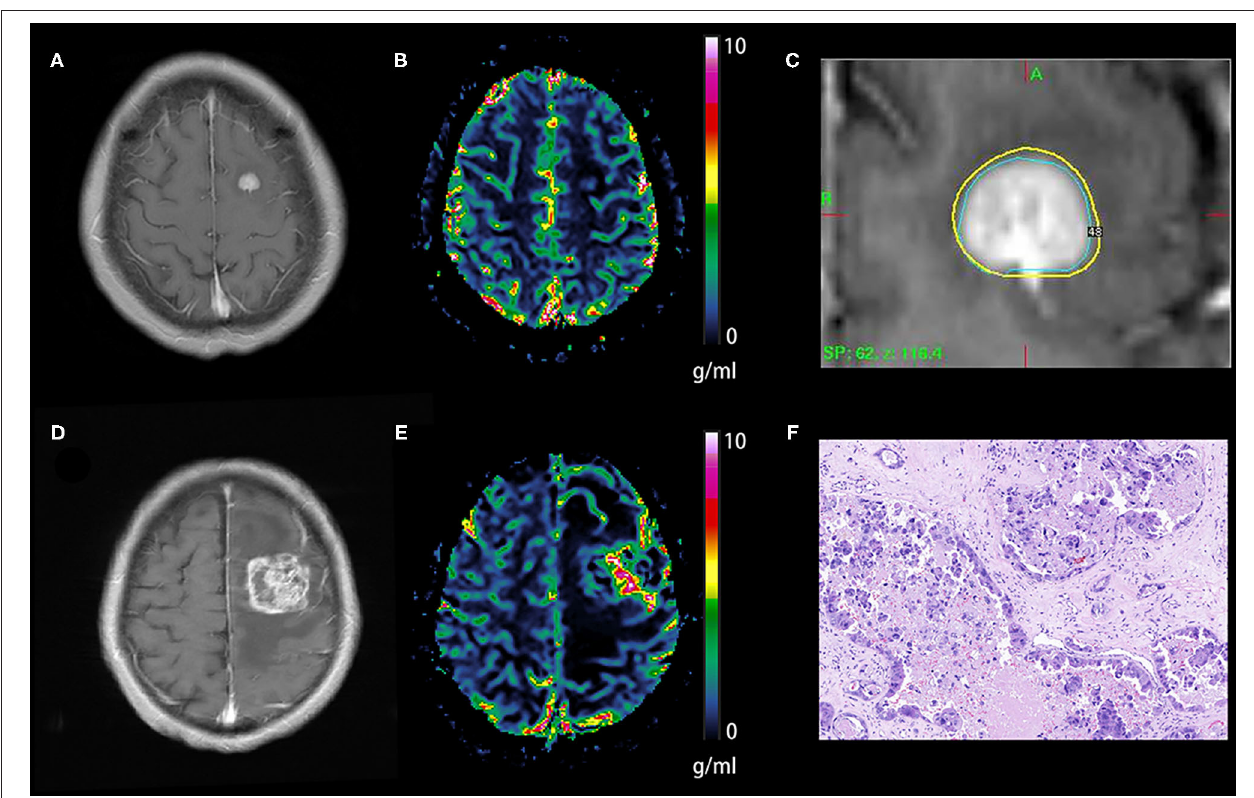
FIGURE 3 | Tumor recurrence of the hypoperfusion BM. An enhancing lesion was discovered in the left frontal lobe of a 50-year-old patient with breast cancer (A) . A quantitative CBV map revealed that the lesion was hypoperfused (B) , and gamma knife radiosurgery was performed later (C) . Ten months later, the enhancing lesion was enlarged (D) , and a quantitative CBV map revealed that the enlarged lesion transformed to hyperperfusion (E) . The lesion was removed via surgical operation, and the pathological result was brain metastasis recurrence (F) . BM, brain metastases; CBV, cerebral blood